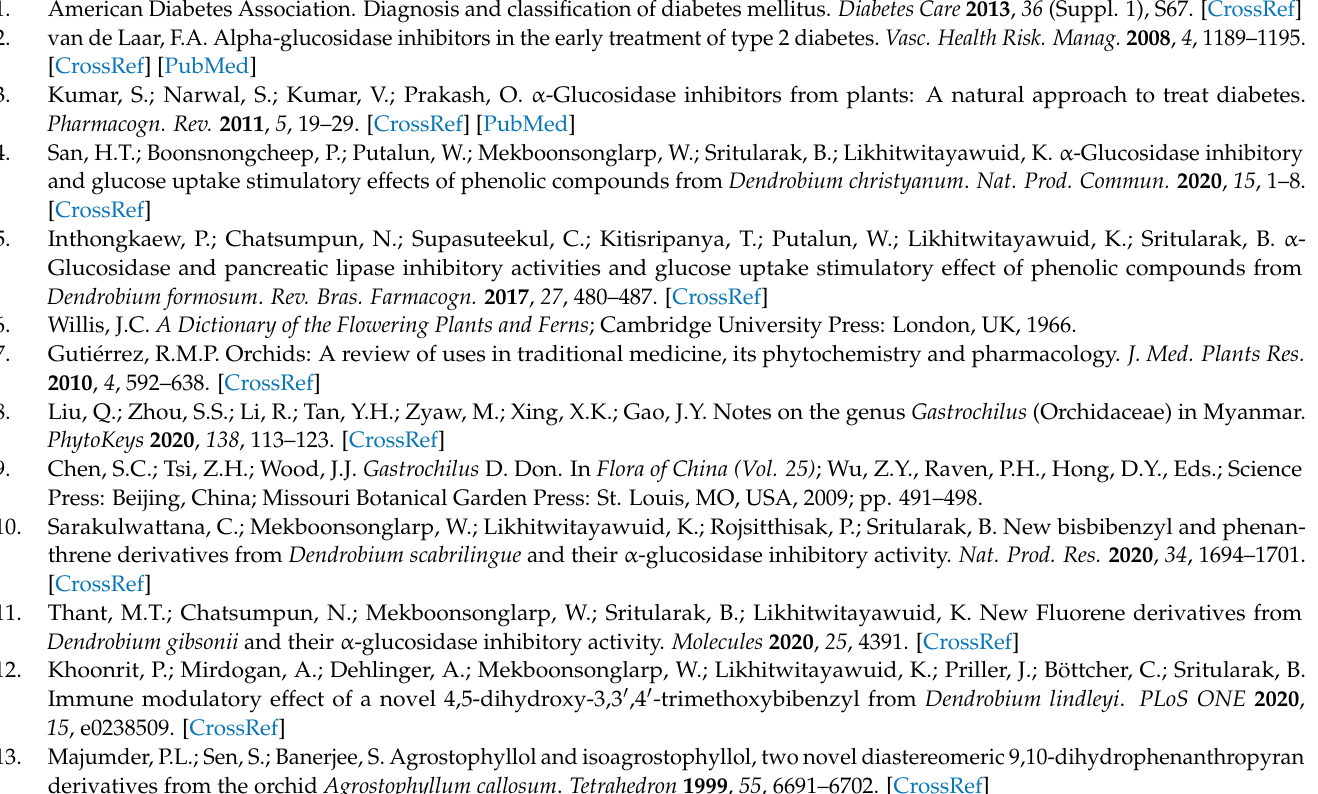
compound 2 , Figure S13: APCI-MS spectrum of compound 3 , Figure S14: 1 H NMR (acetone- d 6 , 300 MHz) spectrum of compound 3 , Figure S15: 13 C NMR and DEPT (acetone- d 6 , 75 MHz) spectrum of compound 3 , Figure S16: HSQC spectrum of compound 3 , Figure S17: HMBC spectrum of compound 3 , Figure S18: NOESY spectrum of compound 3 , Figure S19: APCI-MS spectrum of compound 4 , Figure S20: 1 H NMR (acetone- d 6 , 300 MHz) spectrum of compound 4 , Figure S21: 13 C NMR and DEPT (acetone- d 6 , 75 MHz) spectrum of compound 4 , Figure S22: HSQC spectrum of compound 4 , Figure S23: HMBC spectrum of compound 4 , Figure S24: NOESY spectrum of compound 4